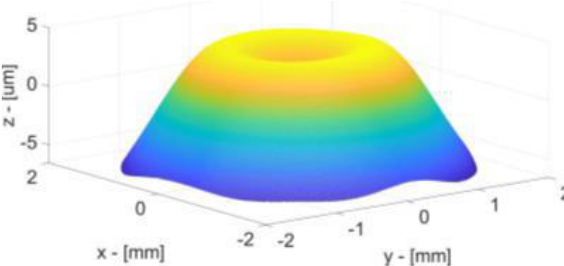
Fig. 1. Measured shape of the wavefront of the SLB, combined spherical and defocus aberrations